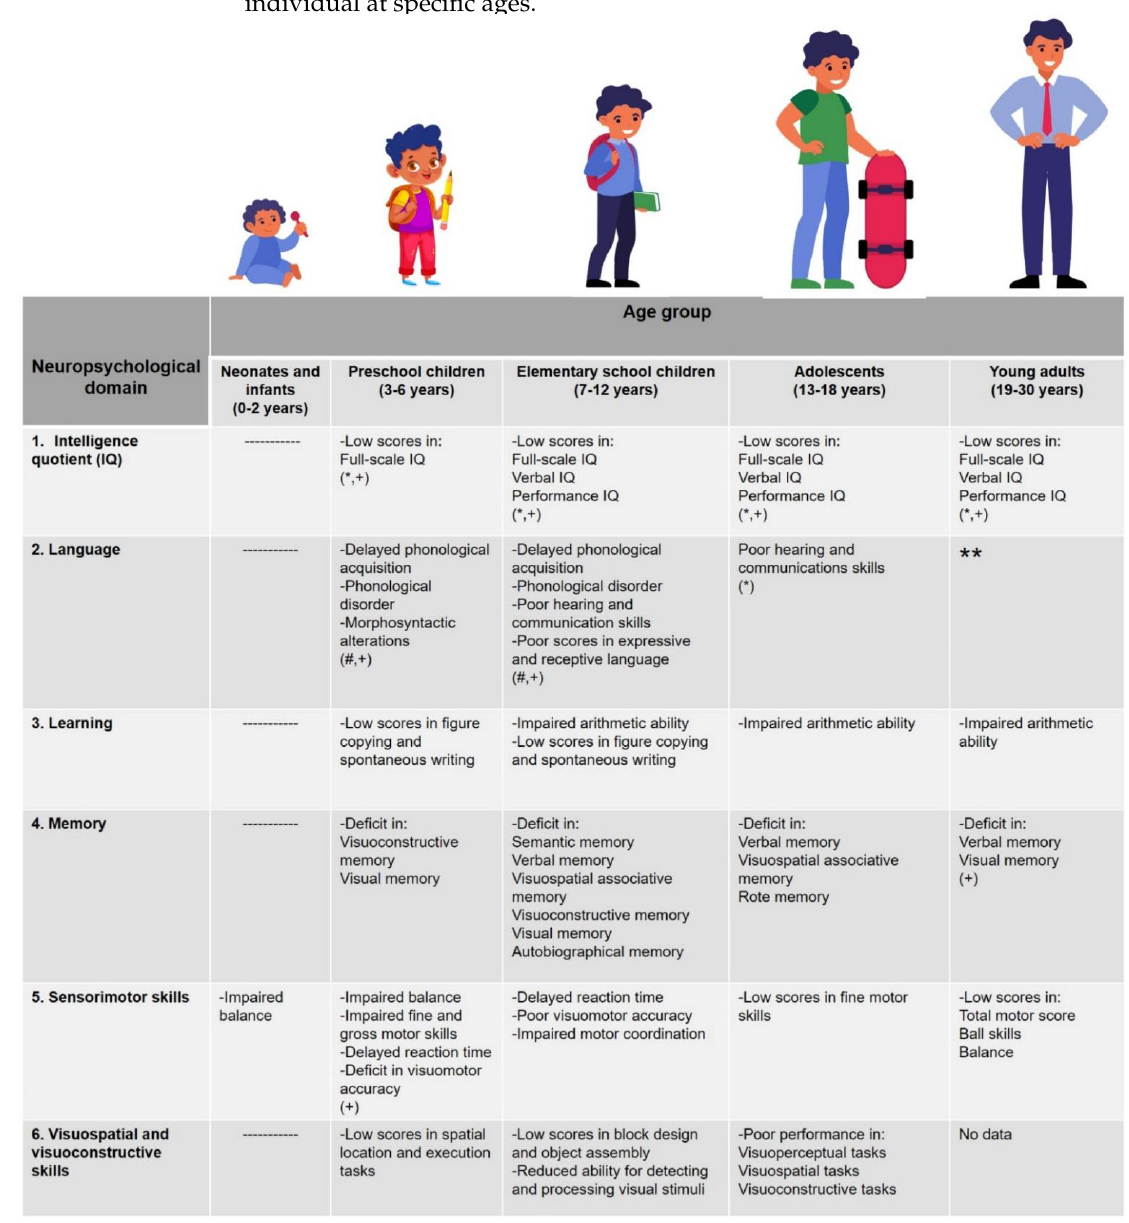
Figure 2. Main neuropsychological alterations reported in CH-Tx patients at different ages. This